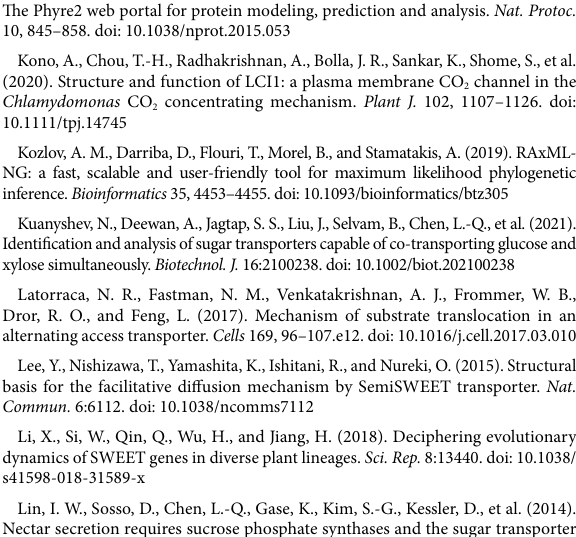
Figueroa-Torres, G. M., Pittman, J. K., and Theodoropoulos, C. (2021). Optimisation of microalgal cultivation via nutrient-enhanced strategies: the Figueroa-Torres, G. M., Wan Mahmood, W. M. A., Pittman, J. K., and Theodoropoulos, C. (2020). Microalgal biomass as a biorefinery platform